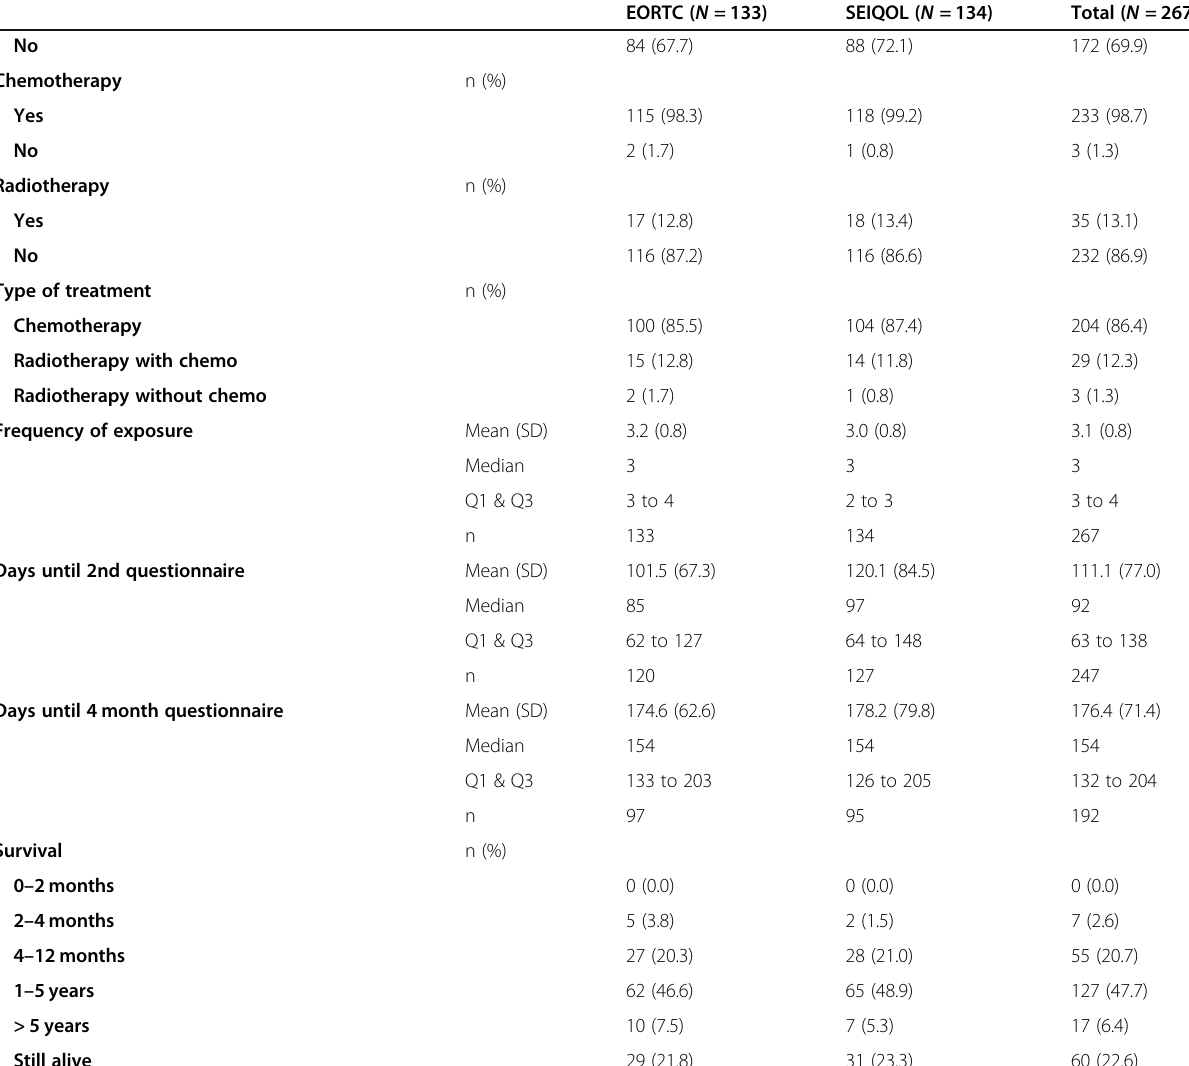
Table 1 Description of patients with at least one intervention